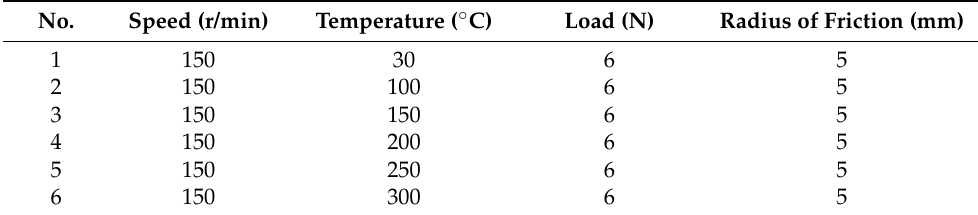
Figure 2. Schematic diagram of the friction and wear test device. Table 3. The parameters of the friction and wear